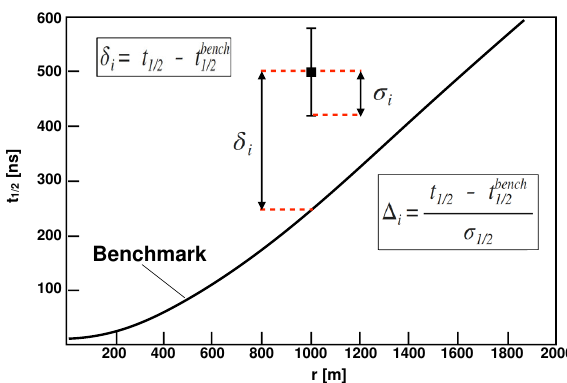
Figure 10. Schematic diagram which shows the definition of ∆ i , as it is build with respect to the benchmark t bench 1 / 2